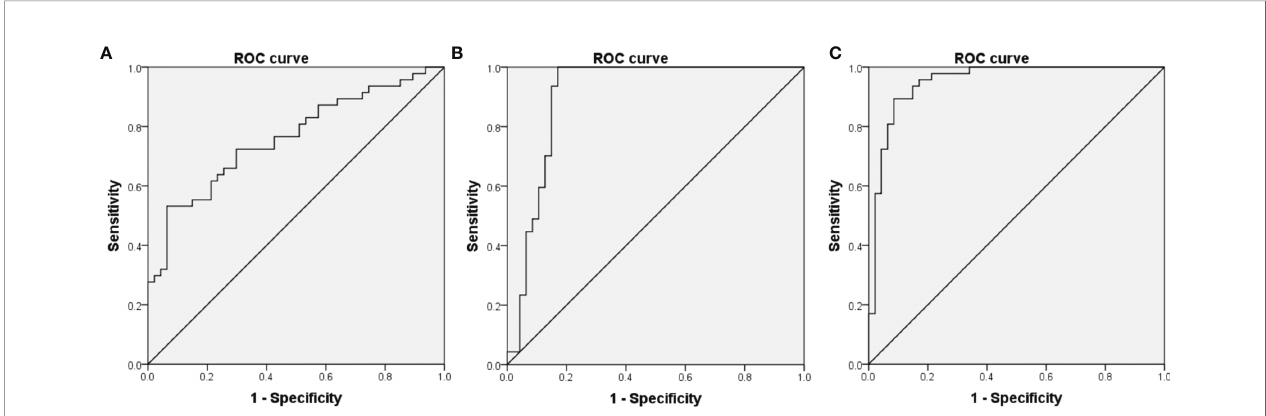
FIGURE 2 | Receiver operating characteristic (ROC) curves for logistic regression models utilizing clinical risk factors (A) , serum putrescine (B) serum putrescine and clinical risk factors (C)